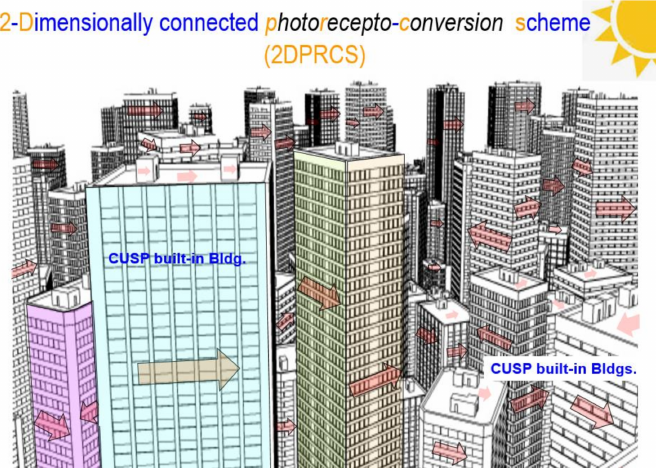
Figure 16. An image of the 2DPRC scheme application in metropolitan areas. Arrows schematically show 3D-to-2D converted sunlight propagating in RWG. The 2DPRC scheme can be used not only for sunlight but also for OWPT or laser power beaming that it is di ffi cult for LSC to be applied